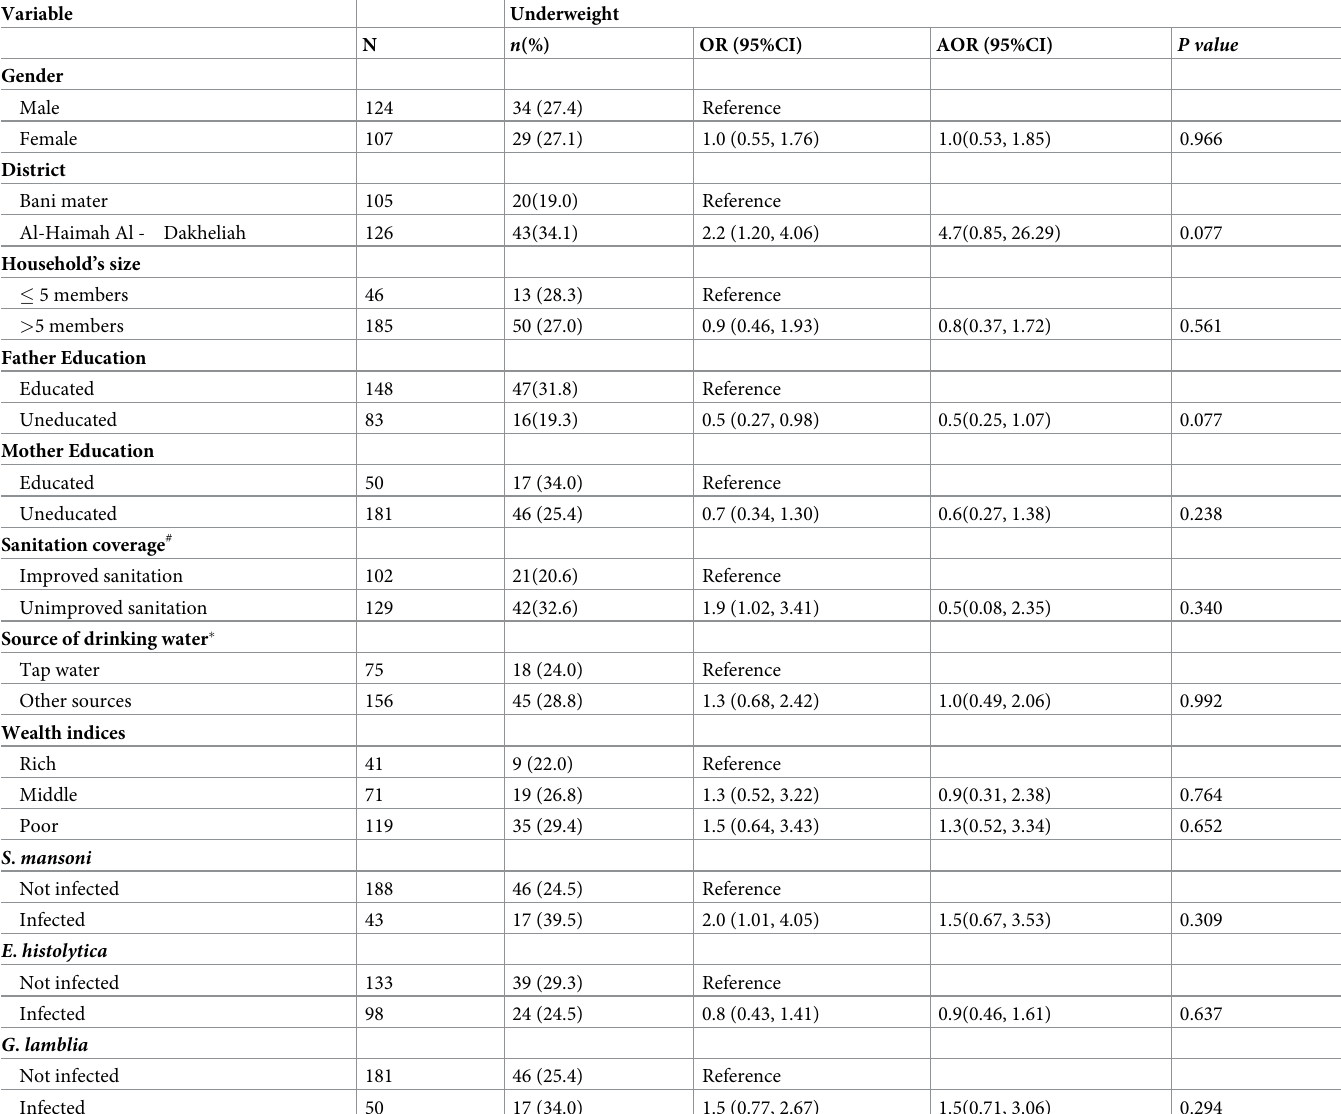
Table 5. Factors associated with underweight among schoolchildren, Sana’a Governorate, Yemen (N =